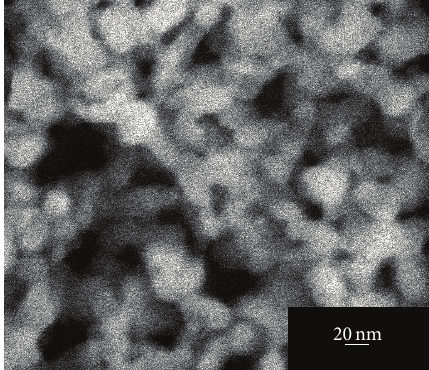
Figure 4: STEM image of a CuS thin film.